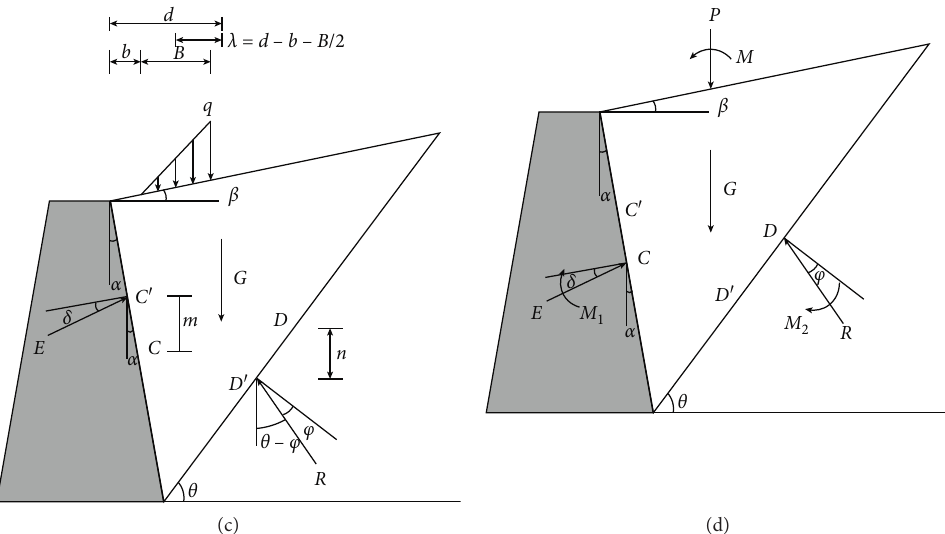
Figure 5: Triangular surcharge condition for the retaining wall. (a) Surcharge locates on the right of backfill gravity center; (b) corre- sponding equivalent moment model. (c) Surcharge locates on the left of backfill gravity center; (d) corresponding equivalent moment